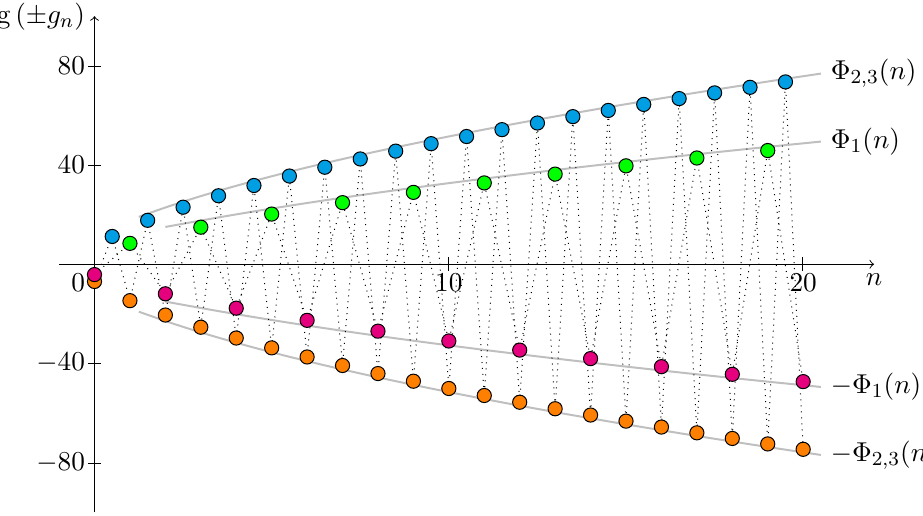
Figure 4 . The lightest string states in the heterotic SO(16) × SO(16) -theory. The three interpolating functions Φ ( n ) , for i = 1 , 2 , 3 , correspond to the three terms Z i the total partition function, and in particular they are simply the degeneracies a ( i ) continuous variable n . Notice that, although Φ physical states, the associated off-shell coefficients are